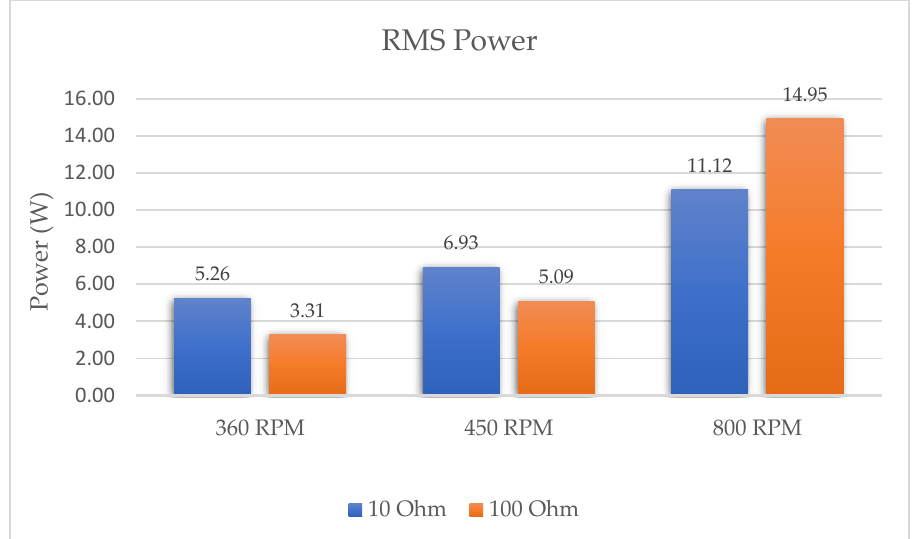
Figure 17. Root mean square power.